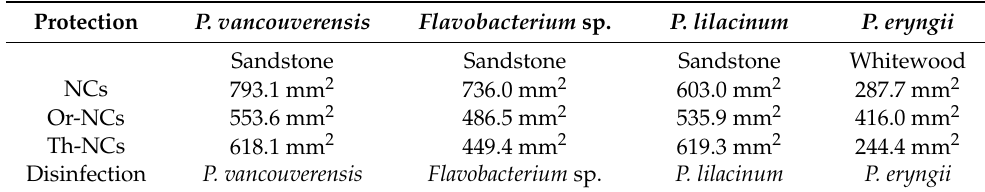
Table 4. Measurement of microbial cells areas on Petri dishes.